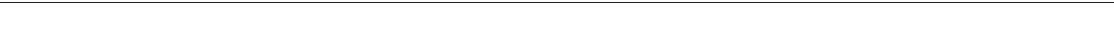
Fig. 3 KaiC phospho-status modulates the binding af fi nity of KaiA for KaiC. a Circadian cycling of the phosphorylation state of KaiC. KaiC harbors two phosphorylation sites: S431 and T432 that undergo the sequential phosphorylation order shown over the circadian cycle 16,30 , where ‘ p ’ means the site is phosphorylated (e.g., ‘ S/pT ’ means that T432 is phosphorylated, but S431 is not). The phosphomimics for each stage in the phosphorylation cycle are shown in parentheses (e.g., ‘ KaiC-AE ’ is the phosphomimic for the ‘ S/pT ’ phosphoform of KaiC). b Various phospho-mimics of KaiC were attached to AP- mica in the CII-end up (C-terminal-up) orientation. KaiA was added to the observation solution and then the dynamic interaction between KaiA and the KaiC phospho-mimics was monitored by HS-AFM in the absence of ATP. The following phospho-mimics were used: DE, KaiC-DE (mimic of pS/pT); DA, KaiC-DA (mimic of pS/T); AE, KaiC-AE (mimic of S/pT), and KaiC-AA (mimic of S/T). Concentration of KaiA, 1 μ M. Frame rate, 1 fps. Scale bars = 20 nm. Also see Supplementary Movies 13 – 16. c Dwell time analysis for KaiA-bound state of phospho-mimics of KaiC observed by HS-AFM. The AFM images used in this analysis were captured at 10 fps. Each black solid line overlaid on the corresponding histogram of dwell time was obtained by fi tting the histogram to a fi rst order reaction model with a time constant ( τ bound ) shown, except for the case of AA, where the value of τ bound could not be